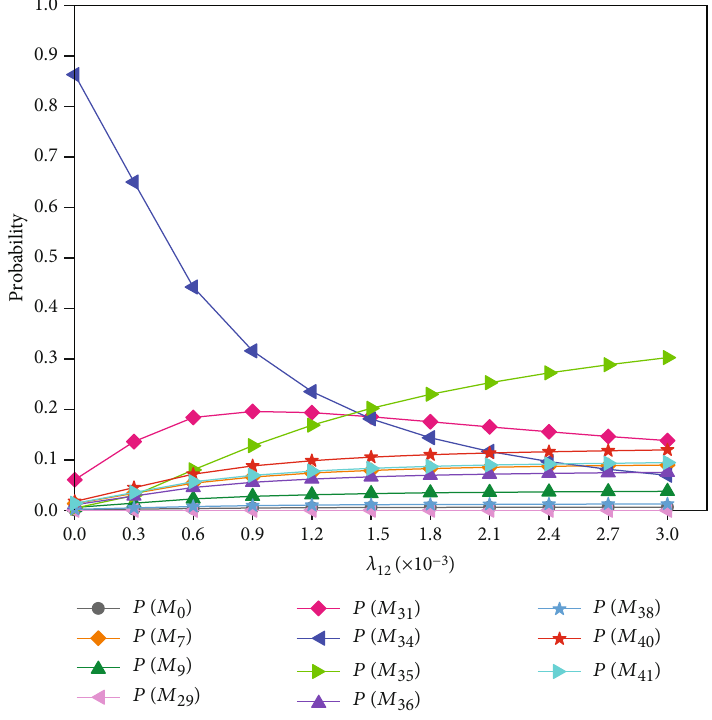
Figure 8: Variation of system probability with change in λ